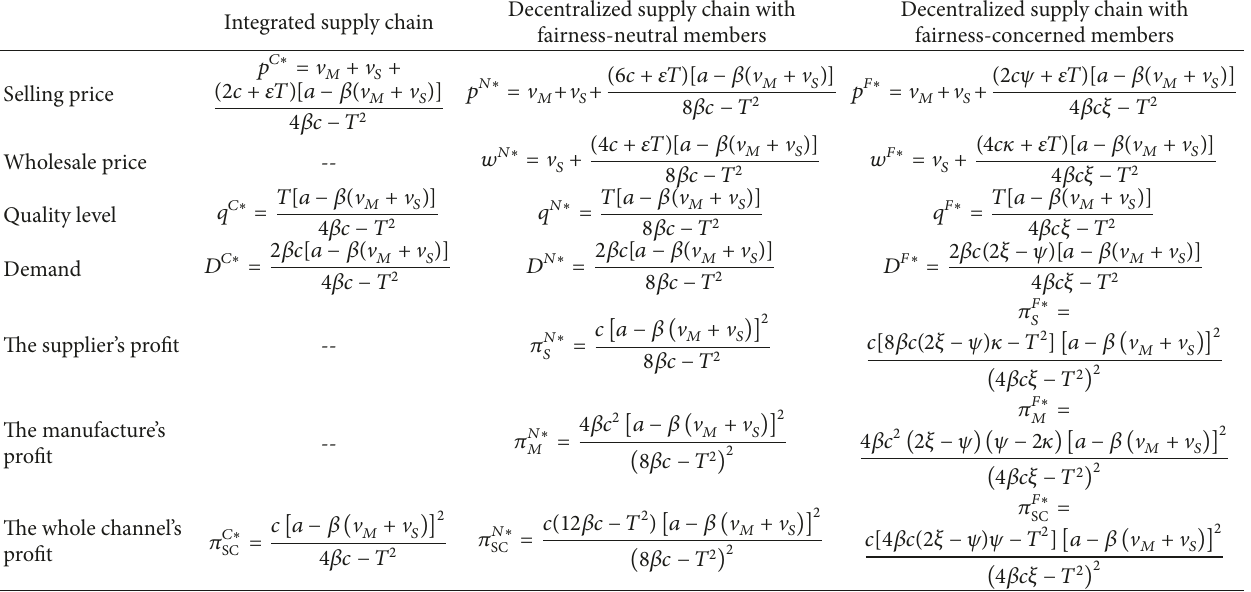
Table 2: The equilibrium solutions under different scenarios when 𝑇 ≥ 0